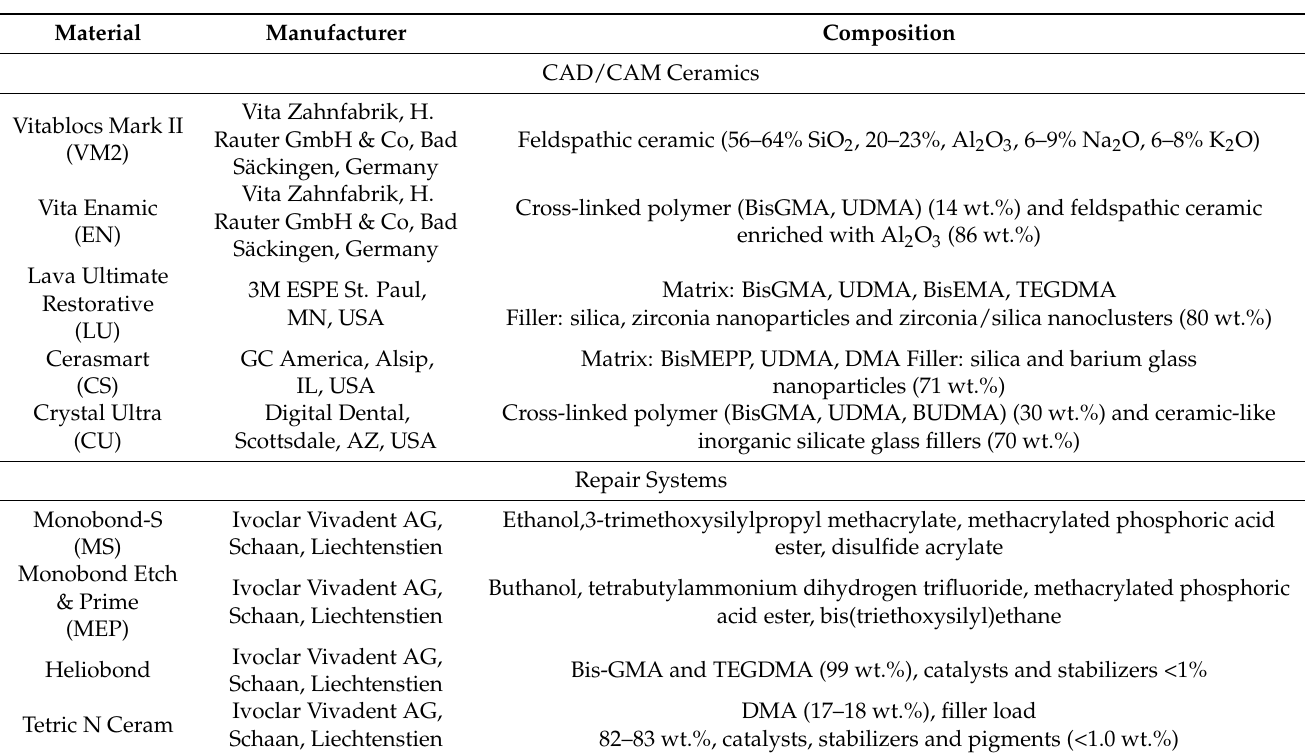
Table 1. Materials evaluated in the